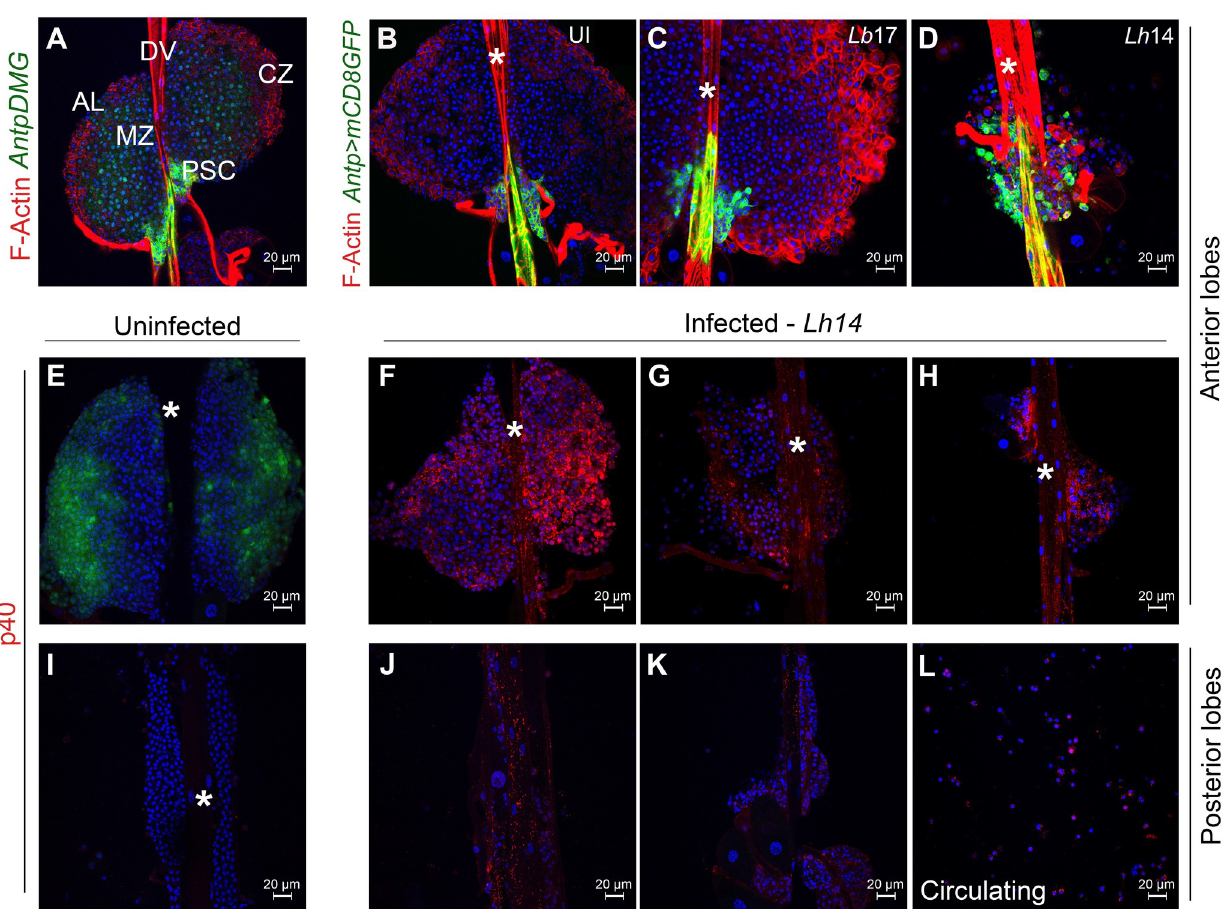
Fig 1. Lh EVs associate with the larval lymphatic system. ( A ) Anterior lobes (ALs, without lamellocytes) from a na ï ve Antp > mCD8GFP Dome- MESO-GFP ( AntpDMG ) animal shows medullary zone (MZ), cortical zone (CZ) and posterior signaling center (PSC). The lobes flank the dorsal vessel (DV, asterisk in other panels). ( B-D ) Anterior lobes from uninfected (UI; B ), Lb - and Lh -infected ( C, D ) Antp > mCD8GFP animals. Lb17 infection induces lamellocyte differentiation in the cortex (lamellocytes are larger than their progenitors and are rich in F-actin). The GFP-positive PSC appears unaffected. Lh14 attack leads to loss of lobe cells; the PSC cells are not tightly-clustered and displaced from their original location. ( E-K ) Lymph glands from Pxn > GFP animals. ( E ) GFP is expressed in the cortex of uninfected animals, but GFP expression is reduced after wasp attack ( F-H ). Lh14 -infected ALs from the same infection experiment showing variability in loss of cells; Lh EVs (anti-SSp40 staining, referred to as p40 here and in remaining figures) are seen in some cells of these lobes and within the dorsal vessel. ( I-K ) Posterior lobes from uninfected ( I ) and Lh -infected animals ( J, K ). ( L ) Circulating hemocytes from infected